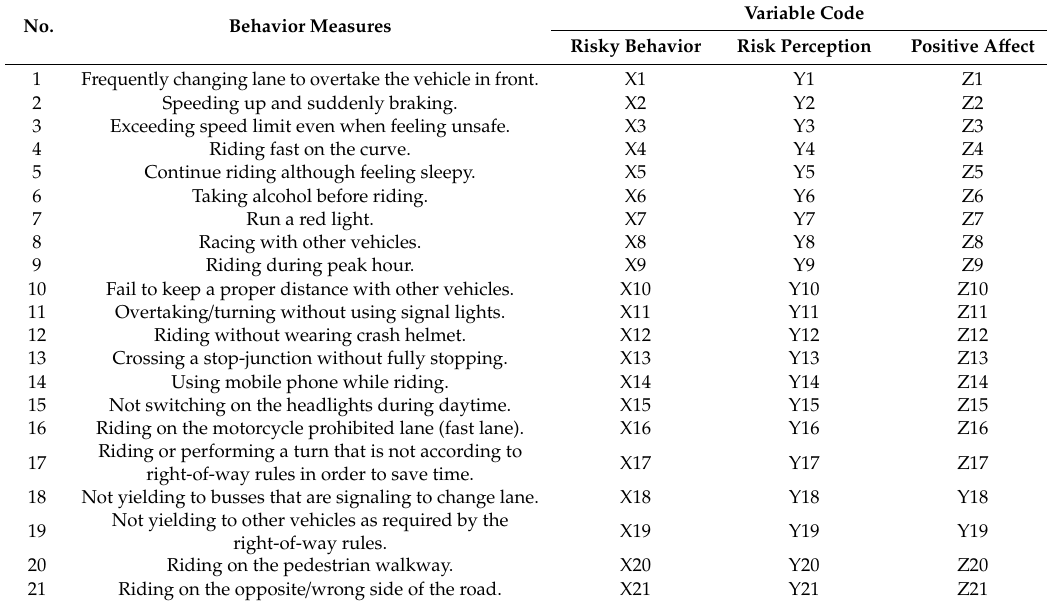
Table 1. Behavior measures and variable